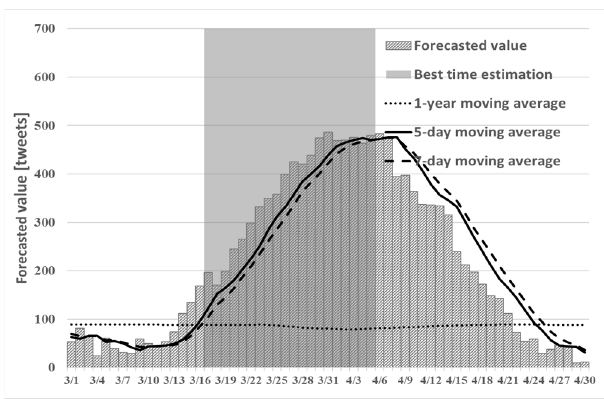
Figure 8. Tokyo after forecasting in 2019 (proposed method (2)).